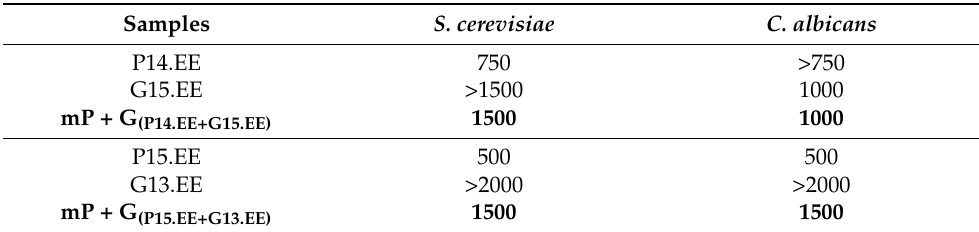
Table 8. MIC values ( µ g/mL) of P.EEs and G.EEs mixtures against Saccharomyces cerevisiae and Candida albicans . The results show the mean ± standard deviation of three assays with three replicates each. Samples P14.EE 750 >750 G15.EE >1500 1000 mP + G (P14.EE+G15.EE) 1500 1000 P15.EE 500 500 G13.EE >2000